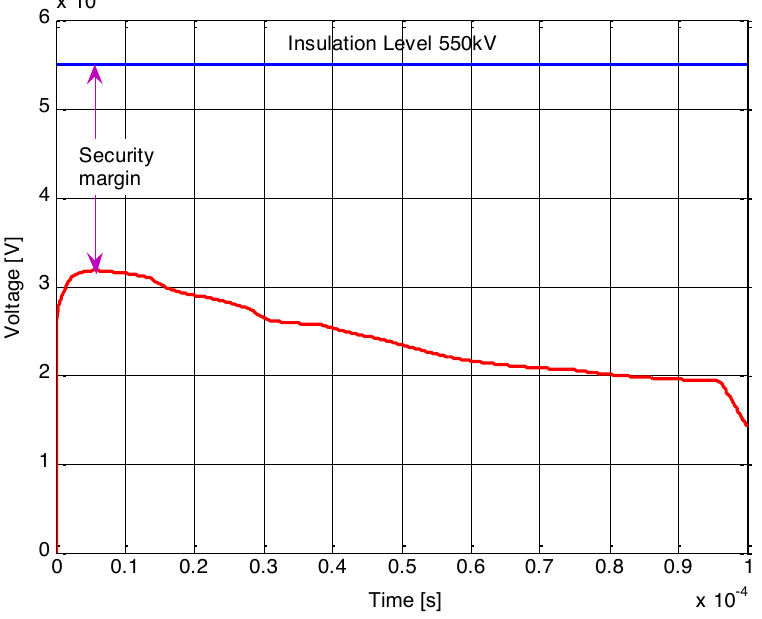
Fig. 8. Residual voltage for discharge current of 20 kA with impulse form 8/20 µs/µs (U r = 315